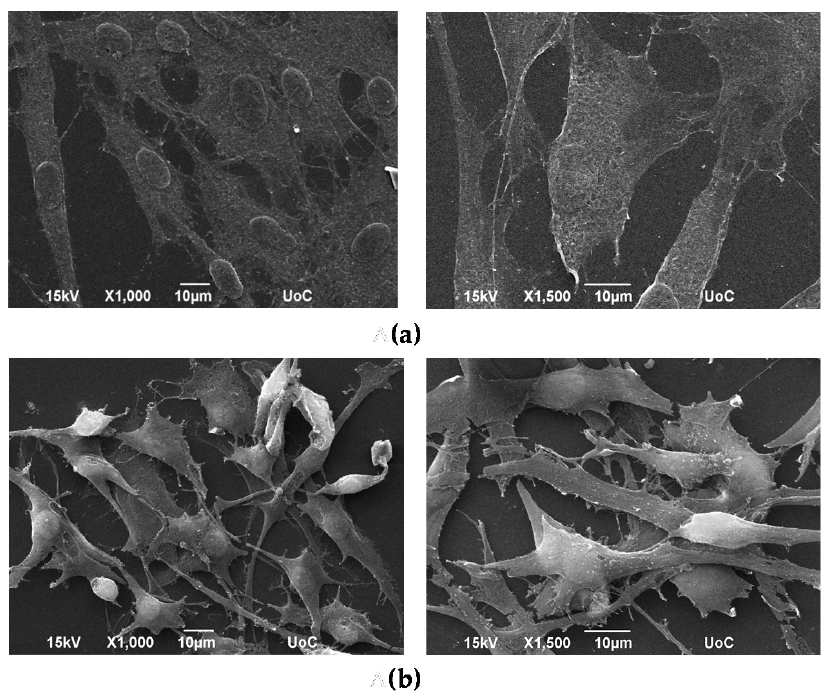
Figure 8. Characteristic SEM images illustrating the morphology of the MC3T3-E1 pre-osteoblastic cells cells cultured for 2 days on ( a ) CS- g -PLLA(80 / 20) and ( b ) CS- g -PLLA(50 / 50) cultured for 2 days on ( a ) CS- g -PLLA(80/20) and ( b ) CS- g -PLLA(50/50) films.